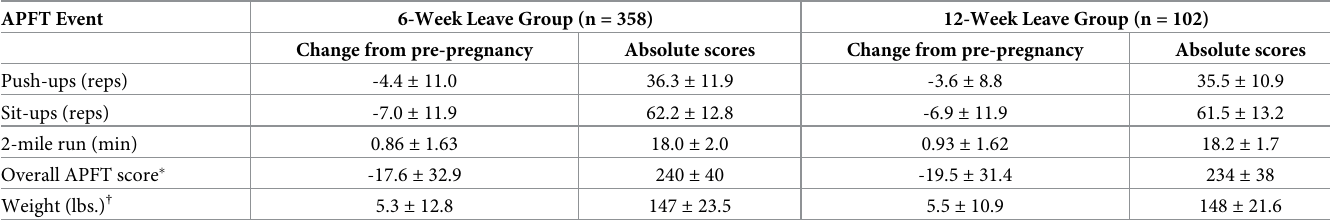
Table 2. Comparison in each APFT measure across pregnancy between 6-week and 12-week cohorts. APFT Event